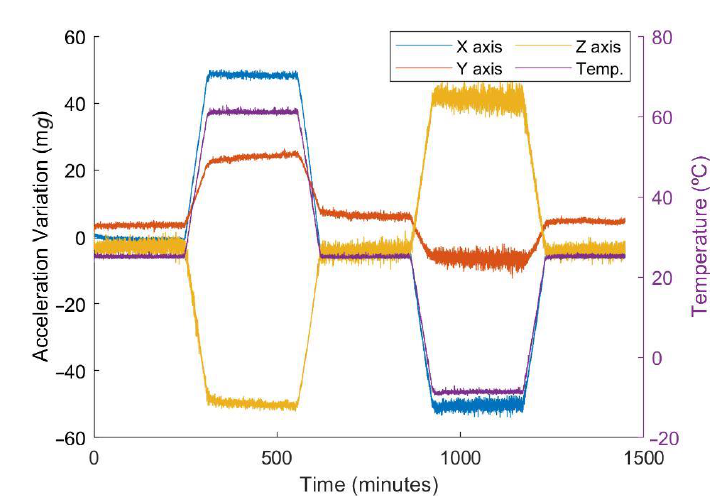
Figure 11. Acceleration drifts and temperature values during the calibration